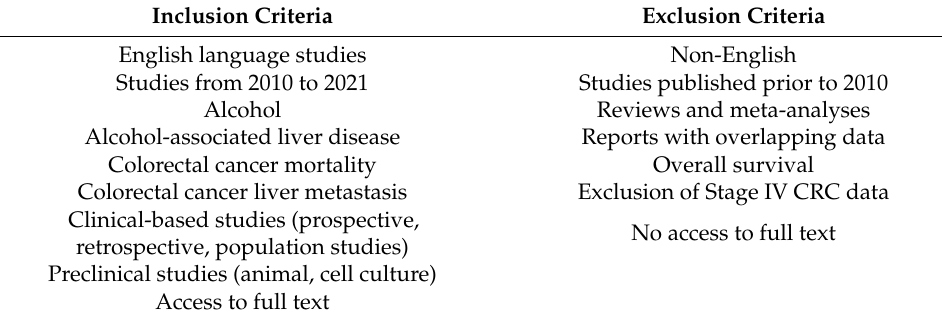
Table 1. Search criteria for alcohol and colorectal cancer (CRC) publications.